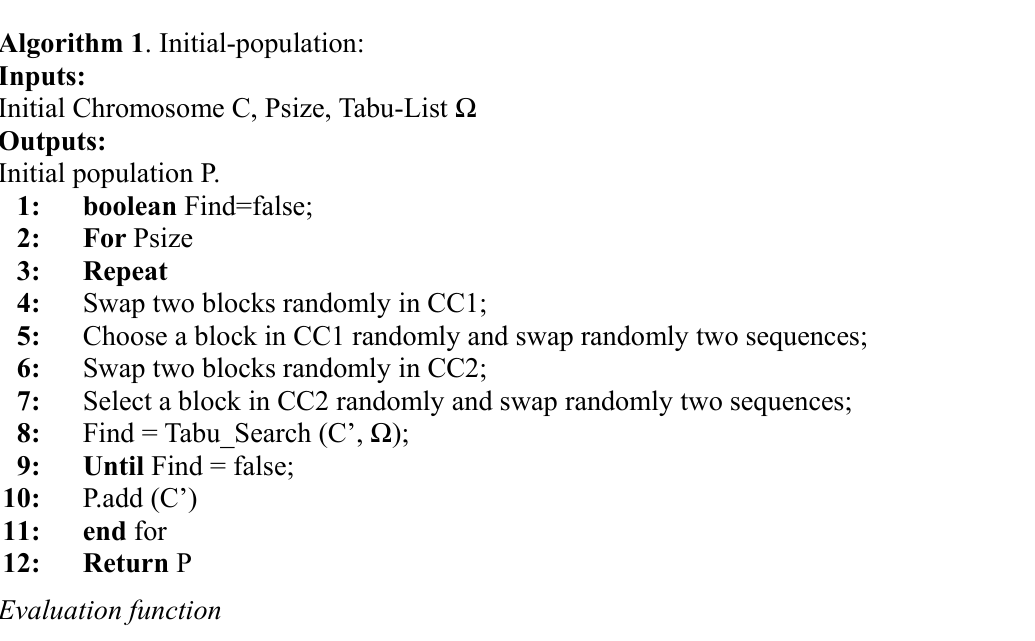
Algorithm 2 . Crossover